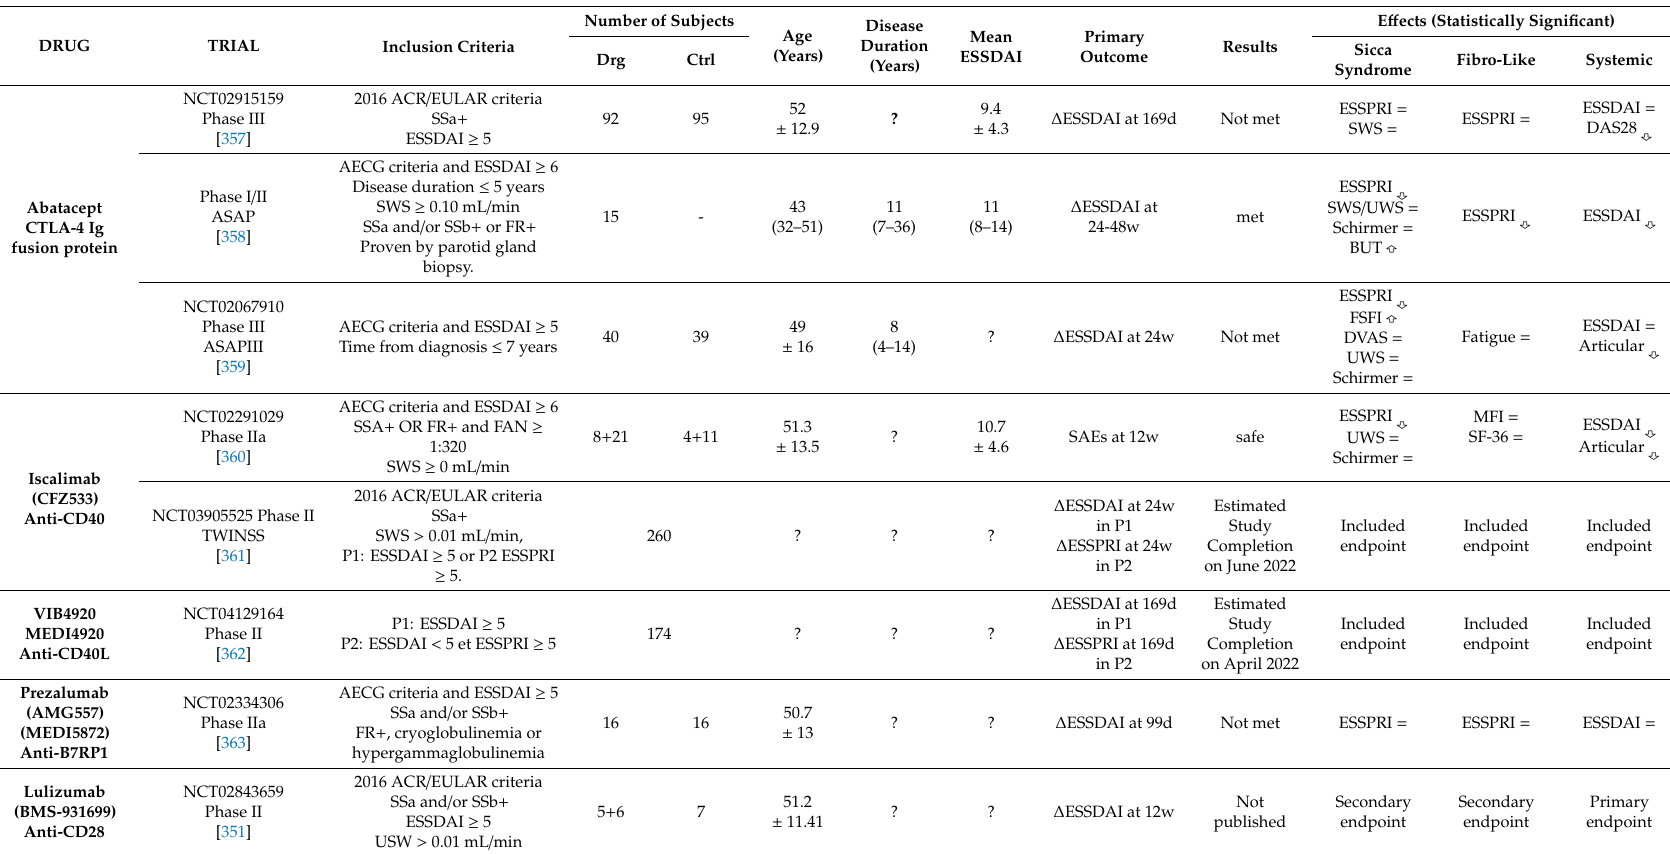
Table 9. T-cell targeted drugs in pSS: co-stimulation receptors or ligands